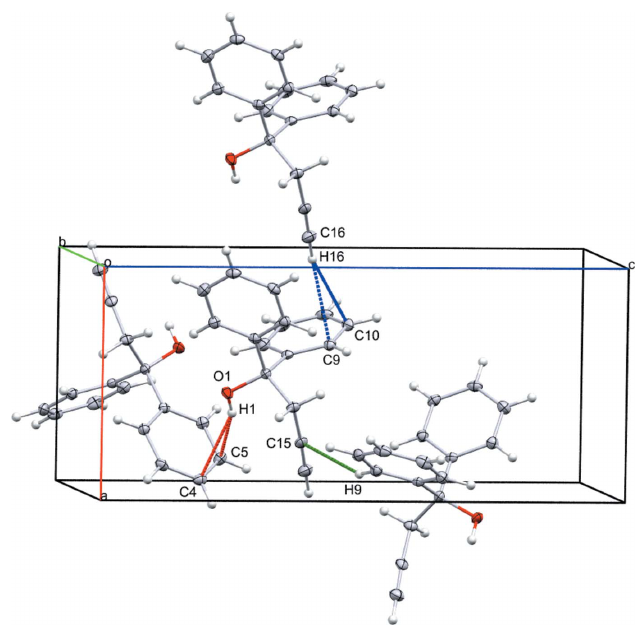
Figure 2 Packing view of the title compound. O–H (cid:2)(cid:2)(cid:2) (cid:2) , terminal alkyne hydrogen atom (cid:2)(cid:2)(cid:2) (cid:2) and terminal alkyne carbon atom with aromatic hydrogen atom contacts are shown, respectively, as red, blue and green dashed lines.